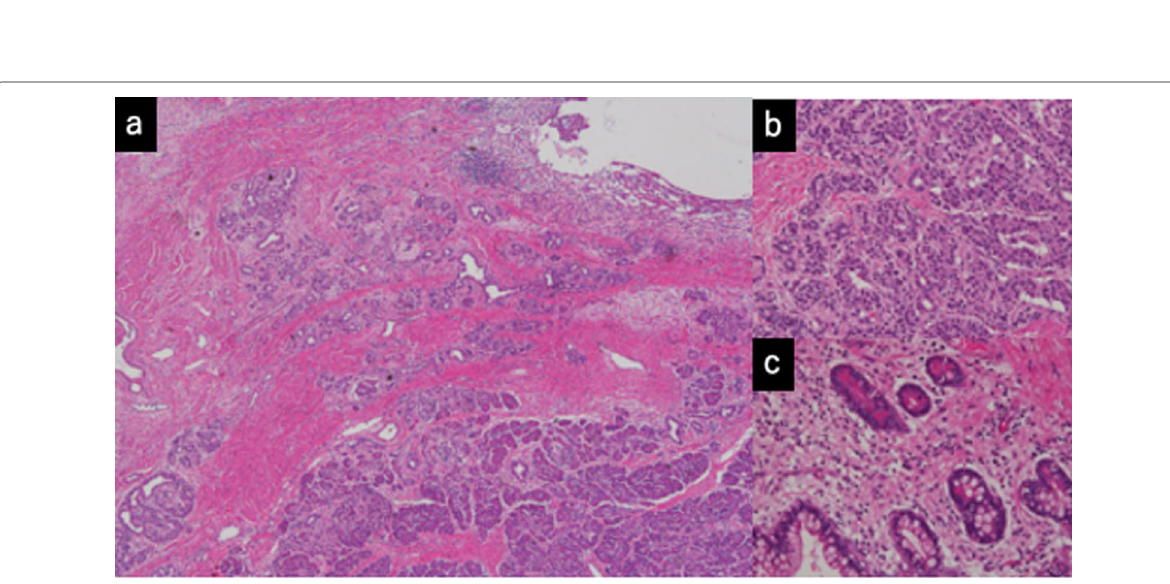
Fig. 5 a Adjacent to the cystic parts, there were solid components that showed pancreatic tissues ( b ); intestinal epithelium with Paneth cells ( c ); cerebral tissues and nervous